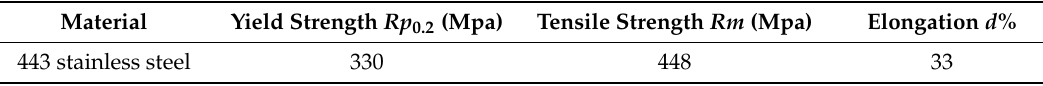
Table 2. Mechanical properties of 443 stainless steel.